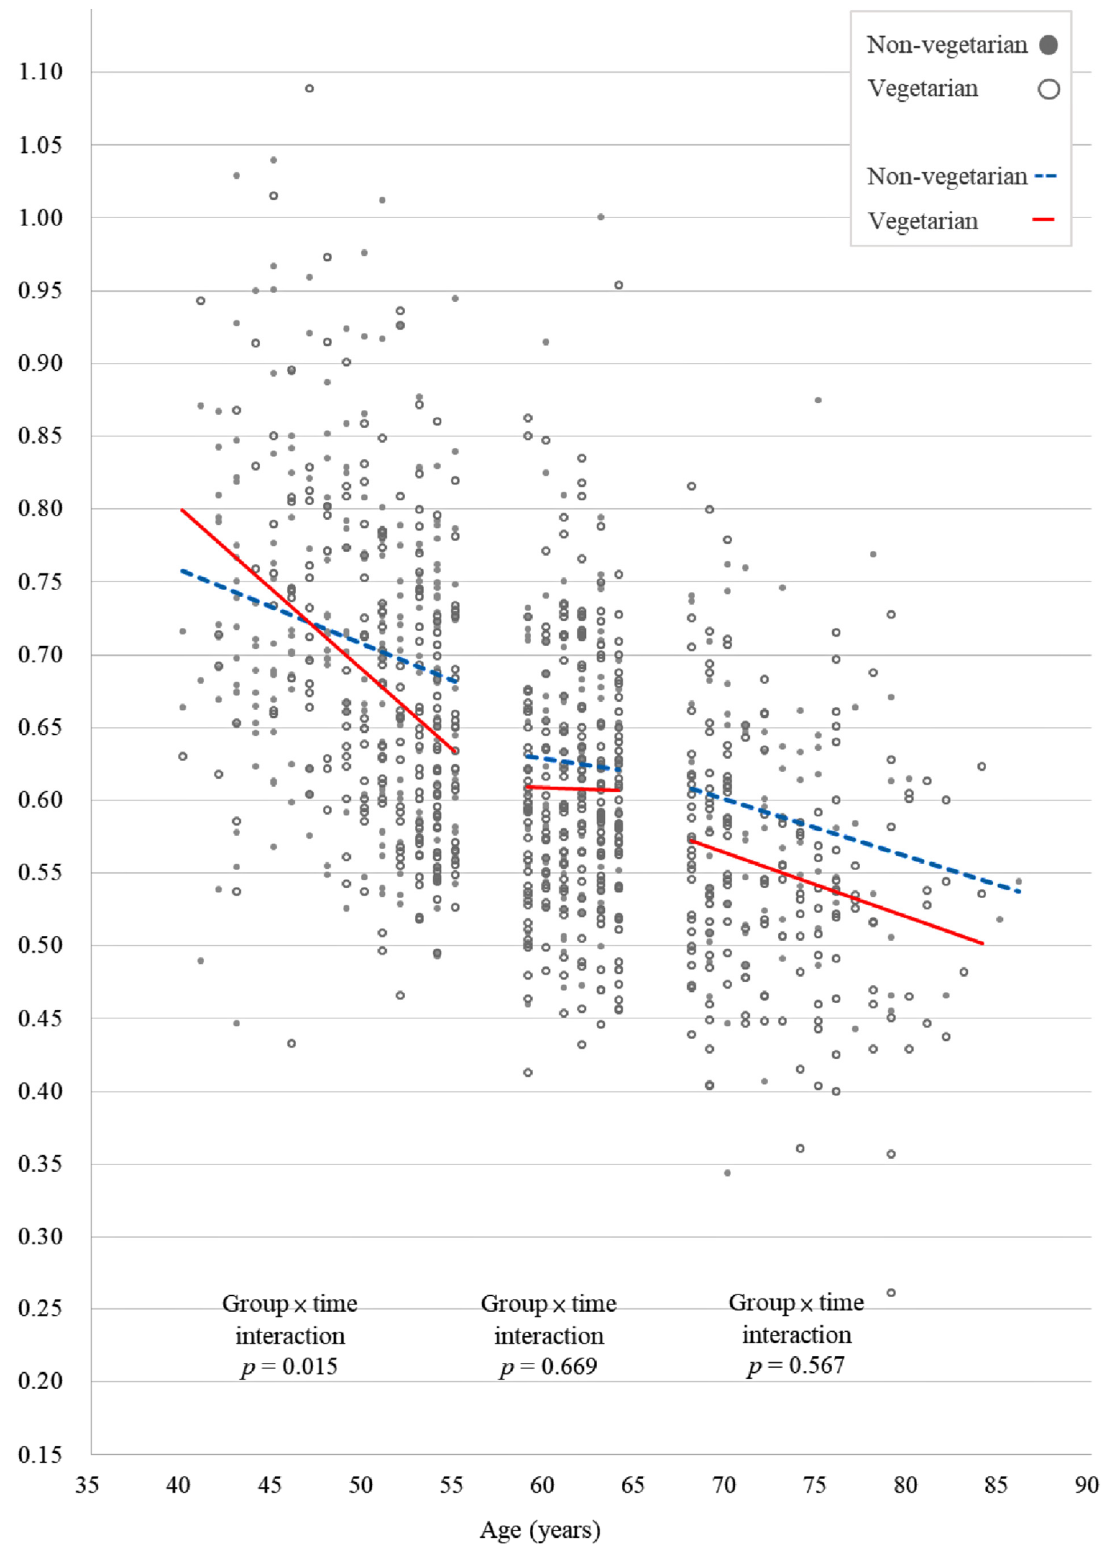
Figure 2. A scatter plot of the effect of the interaction between time and diet on left femoral neck bone mineral density in the three age groups of vegetarian and non-vegetarian women.